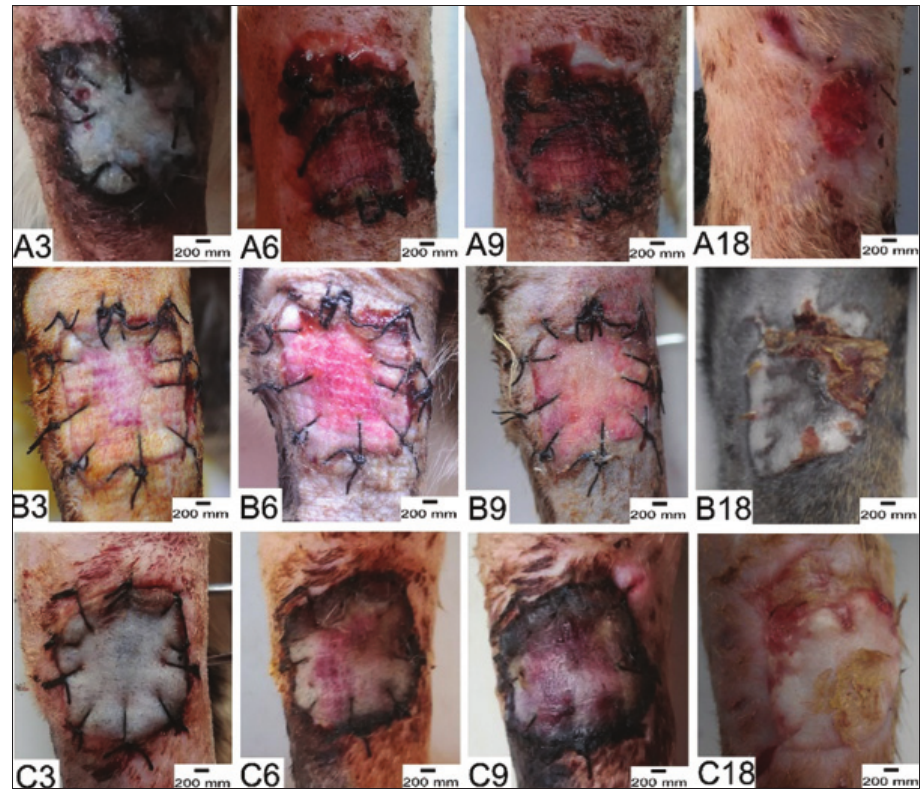
Figure-1: Clinical representation donor’s skin color each group. Group I (A3: Skin graft status after 3 days, A6: Skin graft status after 6 days, A9: Skin graft status after 9 days, and A18: Skin graft status after 18 days), Group II (B3: Skin graft status after 3 days, B6: Skin graft status after 6 days, B9: Skin graft status after 9 days, and B18: Skin graft status after 18 days), and group III (C3: Skin graft status after 3 days, C6: Skin graft status after 6 days, C9: Skin graft status after 9 days, and C18: Skin graft status after 18